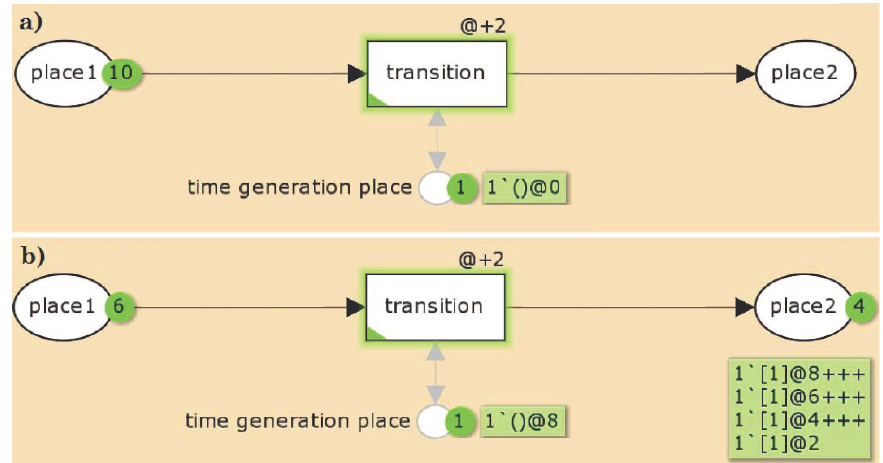
Figure 3. An example for a TPN. The TPN consists of three places, place 1 , place 2 , and a time generation place (TGP), and one transition connected by directed edges with an edge of weight 1 . ( a ) In the initial state of the TPN, place 2 carries no token and place 1 10 tokens, each of them with a time stamp of @0 . There exists a global clock time (not explicitly depicted) which is in the initial state 0 . For the transition, a time delay of @ + 2 is defined, indicating that the time stamp of each token processed by this transition